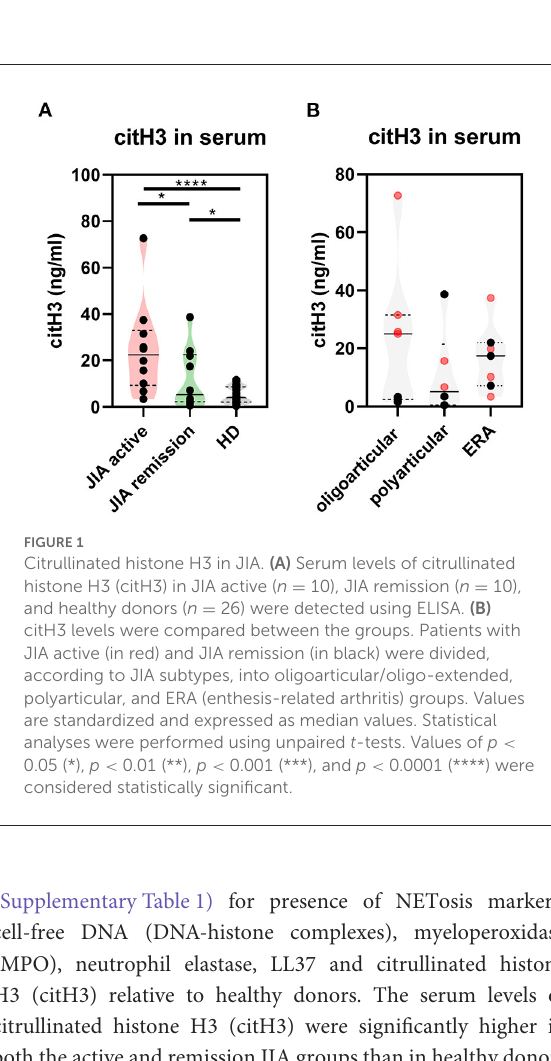
(Supplementary Table 1) for presence of NETosis markers: cell-free DNA (DNA-histone complexes), myeloperoxidase (MPO), neutrophil elastase, LL37 and citrullinated histone H3 (citH3) relative to healthy donors. The serum levels of citrullinated histone H3 (citH3) were significantly higher in both the active and remission JIA groups than in healthy donors (HD) (Figure 1A). Interestingly, we observed clear differences in citH3 concentrations between the oligoarticular/oligo-extended subgroups, but not the polyarticular or enthesis-related JIA (ERA) JIA subgroups, of the active and remission JIA groups. The higher levels were more characteristic for patients with the active state of the disease than those in remission (Figure 1B). This observation implies an increased NETosis and citrullination in patients with